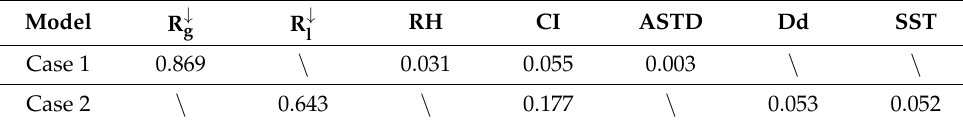
Table 4. The total sensitivity index of each input in Case 1 and Case